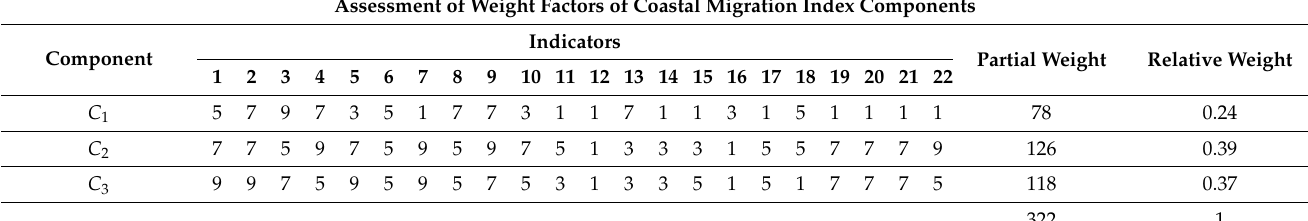
Table A2. Assessment of coefficients n 1 , n 2 and n 3 of the C i components of CMI (Case B: Guama case, Santiago de Cuba, Cuba. See caption of Table A1. explanation of coefficients.